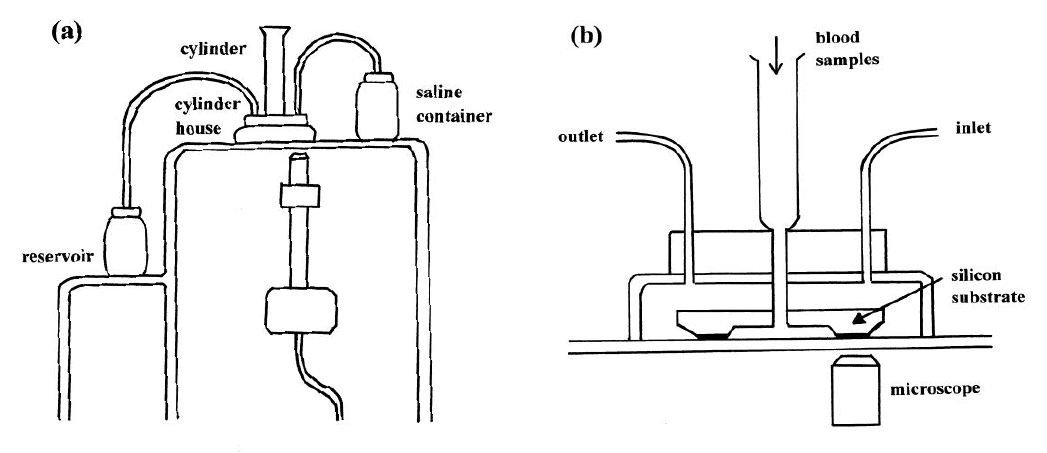
Figure 6. External appearance (a) of a micro-channel array flow analyzer (MC-FAN) and diagram (b) of cylinder house. Blood samples were allowed to flow through the cylinder house by applying a pressure difference of 20 cm H container and